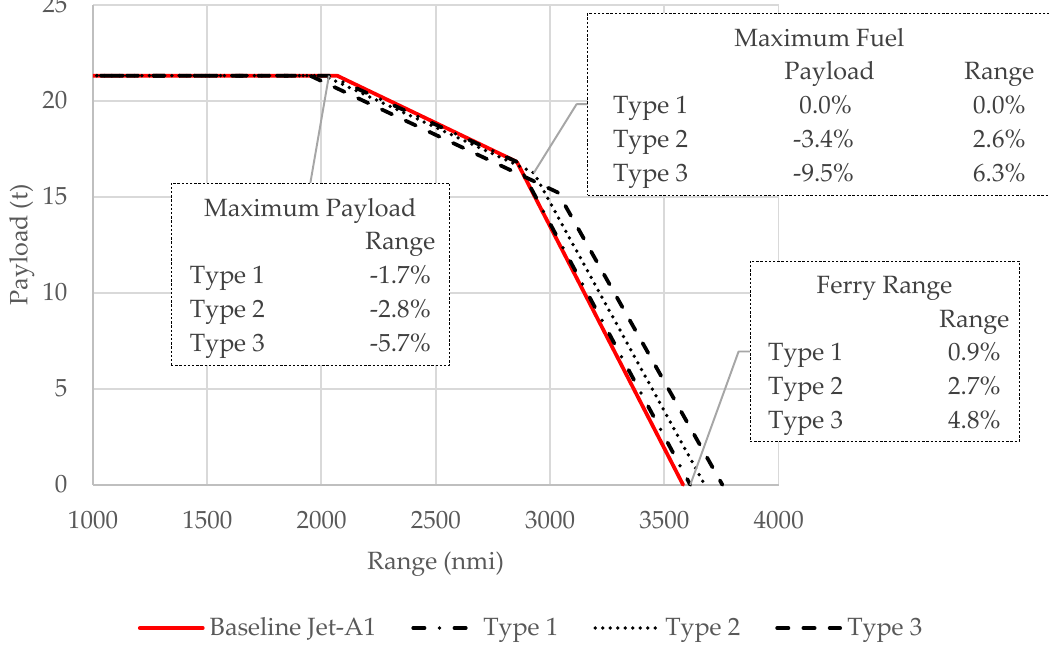
Figure 10. Payload-to-range diagram for the baseline model and the LNG variant with three fuel options.